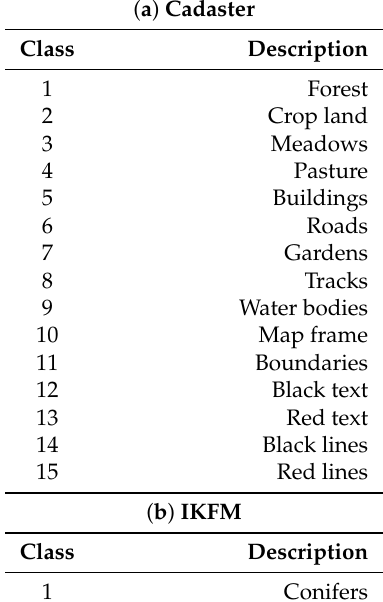
Table 2. Land use/land cover (LULC) classes for the test maps: 1859 cadaster map (a), 1936 Italian Kingdom Forest Map (IKFM) (b) and 1992 Map of the Potential Limit of the Forest in Trentino (MPLFT)